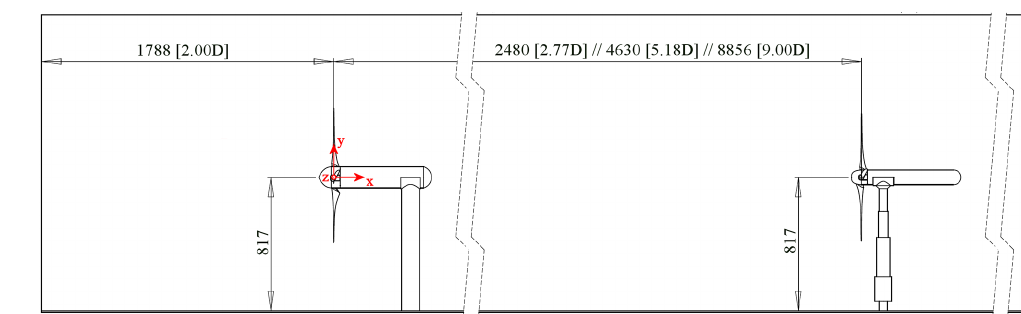
Figure 2. Setup of the model wind turbines in the wind tunnel and reference coordinate system.